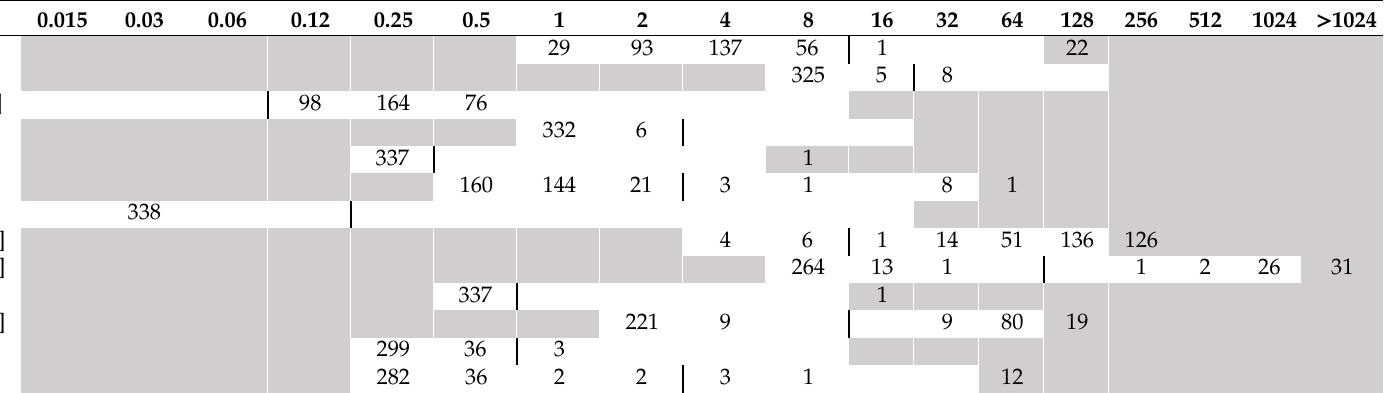
Minimum inhibitory concentration distribution for all quinolone resistant E. coli isolates in this study ( n = 338). Vertical lines denote the epidemiological cut-o ff (ECOFF) values for each antimicrobial, defined by EUCAST. The abbreviated antimicrobial names are listed in the column “AM”; AMP = ampicillin, CHL = chloramphenicol, CIP = ciprofloxacin, COL = colistin, CTX = cefotaxime, GEN = gentamicin, MEM = meropenem, NAL = nalidixic acid, SMX = sulfamethoxazole, CAZ = ceftazidime, TET = tetracycline, TGC = tigecycline, and TMP = trimethoprim. Percent resistances, based on the ECOFF values, are listed in the column “Percent”, with 95% confidence intervals for each respective antimicrobial. White areas denote the range of concentrations tested for each antimicrobial. Numbers outside this area denote growth on all test concentrations. Azithromycin was excluded from this table as no ECOFF value is currently defined by EUCAST for this